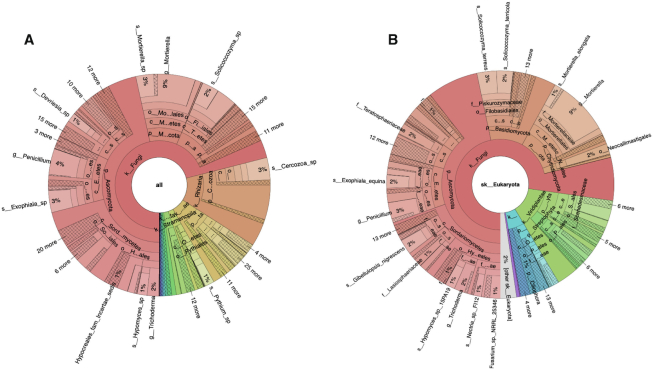
Krona plots showing ITS-based taxonomic analysis results for sequencing run ERR2237853 from agricultural soil. Panel A shows the analysis results obtained using the UNITE database and B shows those produced with ITSoneDB. These plots are integrated into the taxonomy tab within the analysis results section, https://www.ebi.ac.uk/metagenomics/analyses/MGYA00383253#taxonomic.